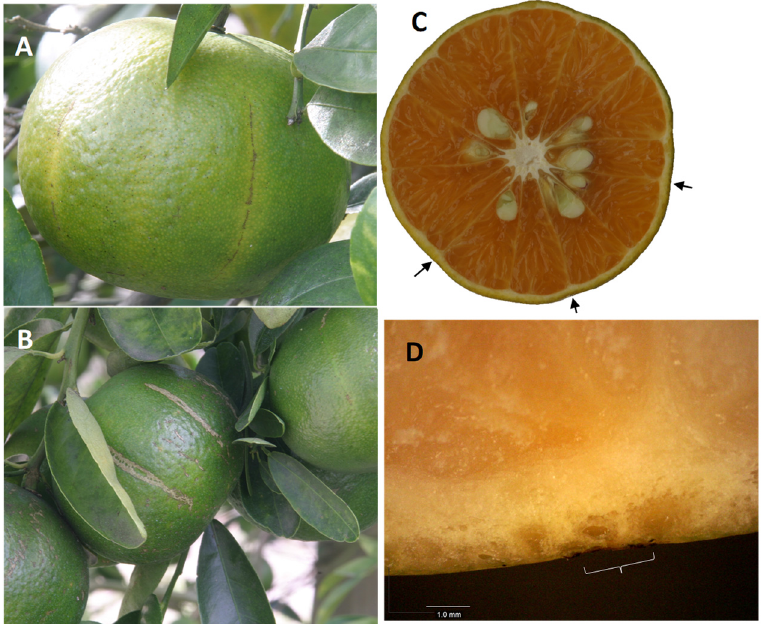
Figure 3. Narrow ( A ) and wide ( B ) longitudinal scars in ‘Murcott’ mandarin fruits. One fruit was cut to show peel below scars (arrows) ( C ). Scars align with section membranes. The sectioned fruit shows variability in peel thickness within a fruit. Closeup of scarred area ( D ) shows slight abnormalities below scar (bracket).